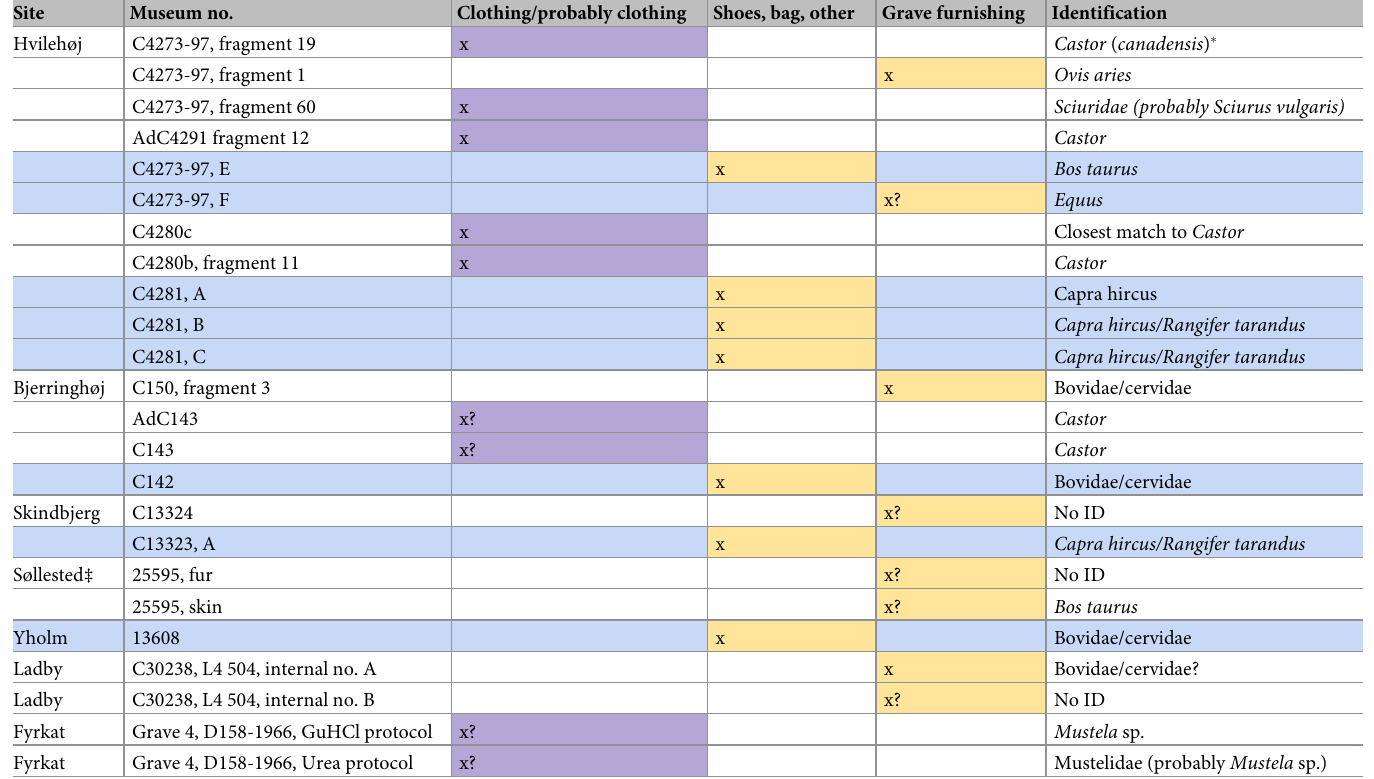
Table 2. Suggested categories of skin and fur and the animal resources they derive from. Site Museum